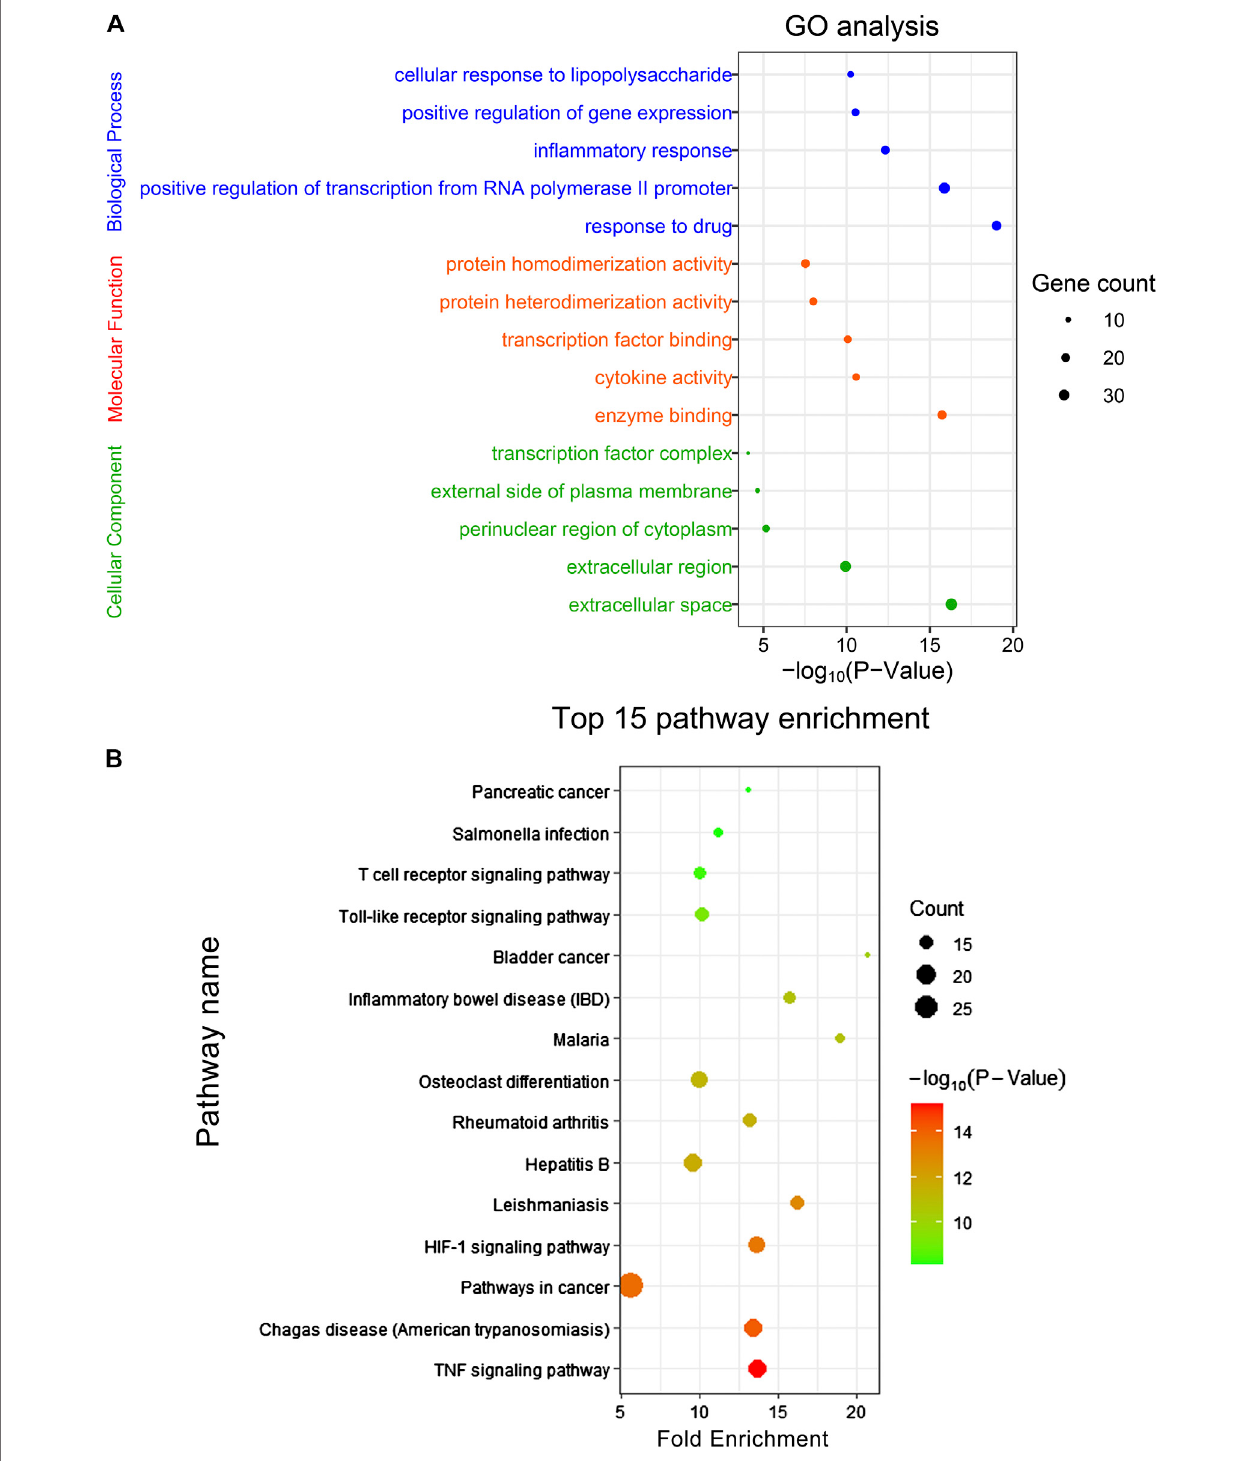
FIGURE 8 | (A) GO analysis and (B) KEEG signaling pathway enrichment of the common targets. The size of the dot indicates the number of target genes in the pathway and the color of the dot re fl ects the p values.